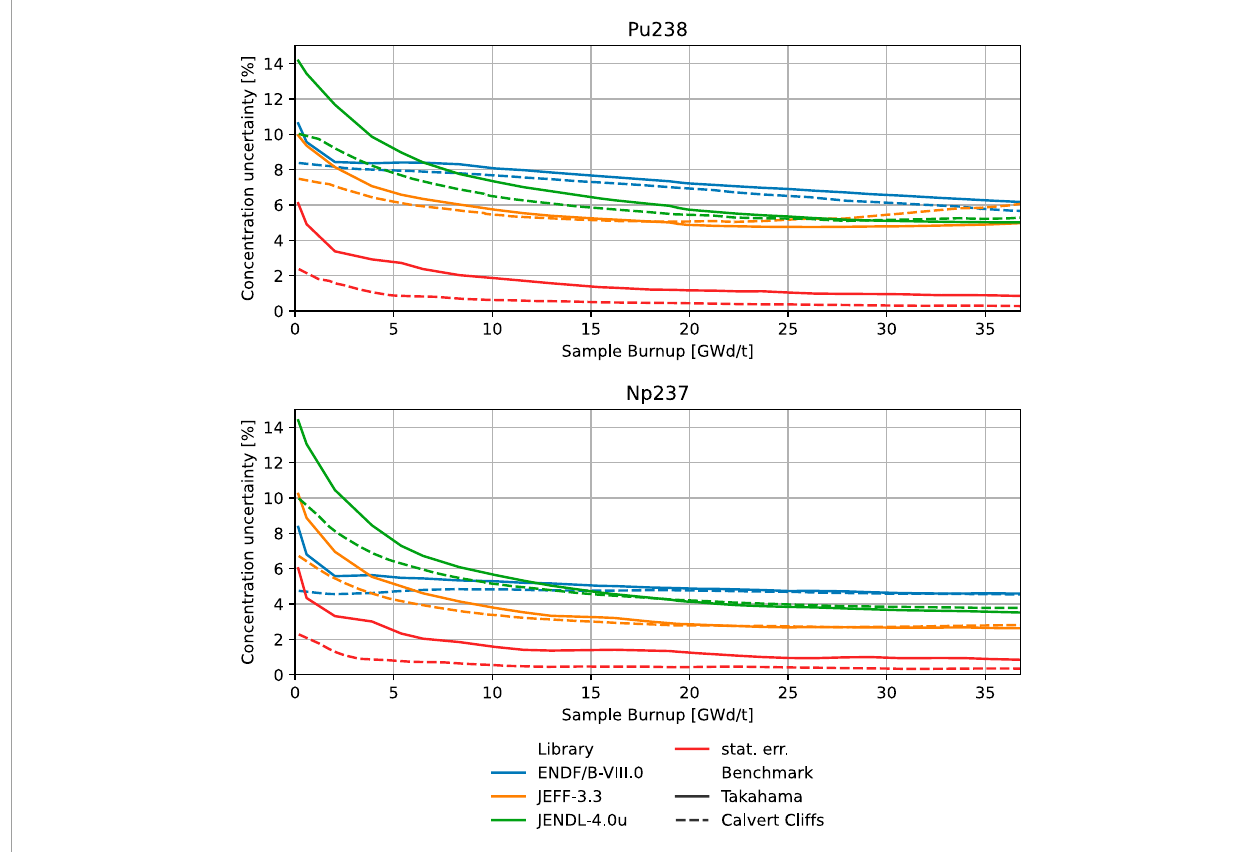
FIGURE 7 Concentration uncertainty evolution with burnup for nuclides 238 Pu (top) and 237 Np